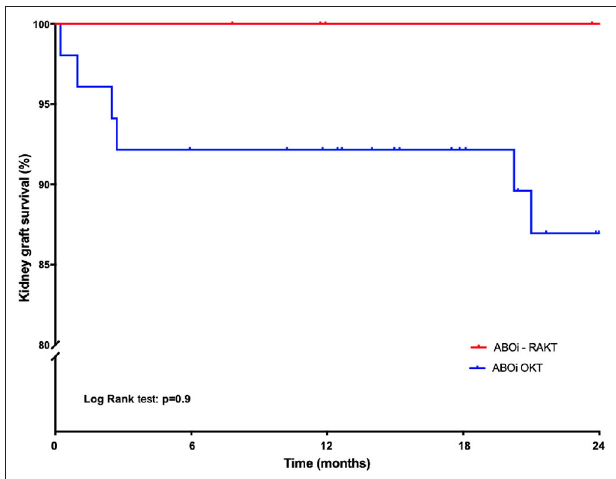
FIGURE 2 | Kaplan-Meier kidney graft survival in the ABOi-RAKT and ABOi-OKT